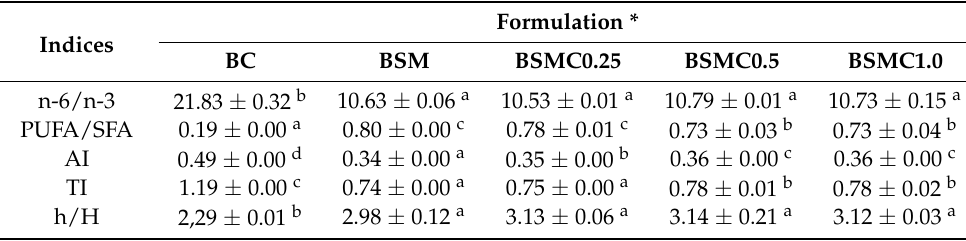
Table 6. Health indices of cooked beef burgers reformulated with gelled emulsion of maca flour, soybean oil, and chincho essential oil used as substitutes for pork backfat. Formulation * Indices BC BSM BSMC0.25 BSMC0.5 BSMC1.0 n-6/n-3 21.83 ± 0.32 b 10.63 ± 0.06 a 10.53 ± 0.01 a 10.79 ± 0.01 a 10.73 ± 0.15 a PUFA/SFA 0.19 ± 0.00 a 0.80 ± 0.00 c 0.78 ± 0.01 c 0.73 ± 0.03 b 0.73 ± 0.04 b AI 0.49 ± 0.00 d 0.34 ± 0.00 a 0.35 ± 0.00 b 0.36 ± 0.00 c 0.36 ± 0.00 c TI 1.19 ± 0.00 c 0.74 ± 0.00 a 0.75 ± 0.00 a 0.78 ± 0.01 b 0.78 ± 0.02 b h/H 2,29 ± 0.01 b 2.98 ± 0.12 a 3.13 ± 0.06 a 3.14 ± 0.21 a 3.12 ± 0.03